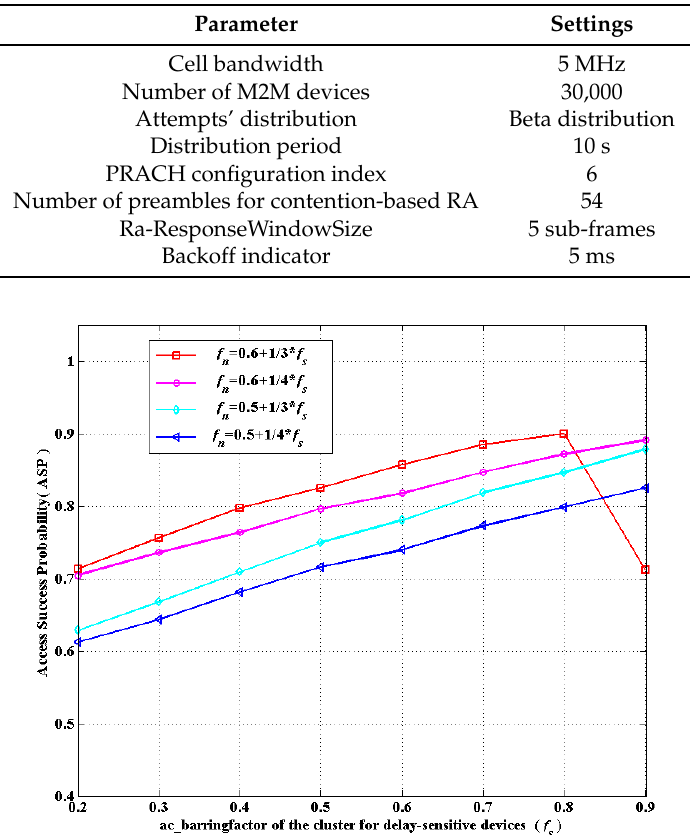
Table 1. Basic simulation parameters.